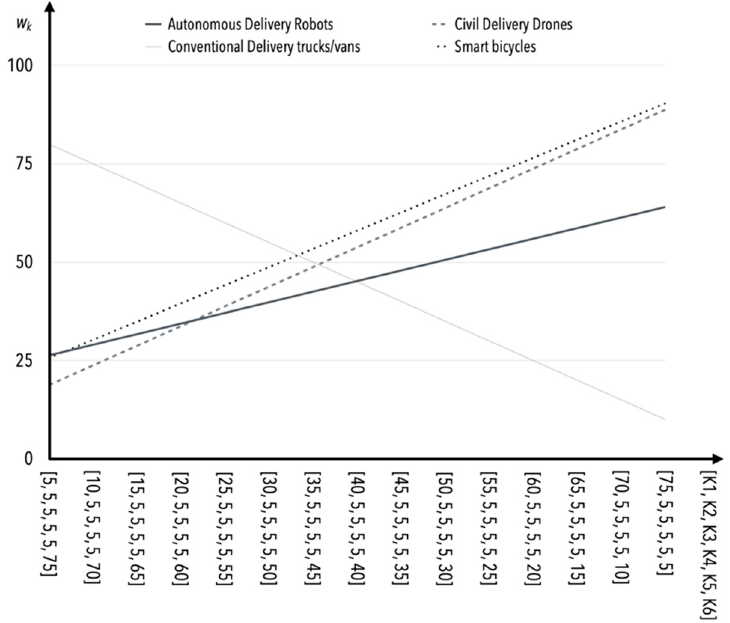
Figure 3. The influence of weight value changes for criterion K 2 on criteria K 1, K 3 –K 5 (in the case of S1).